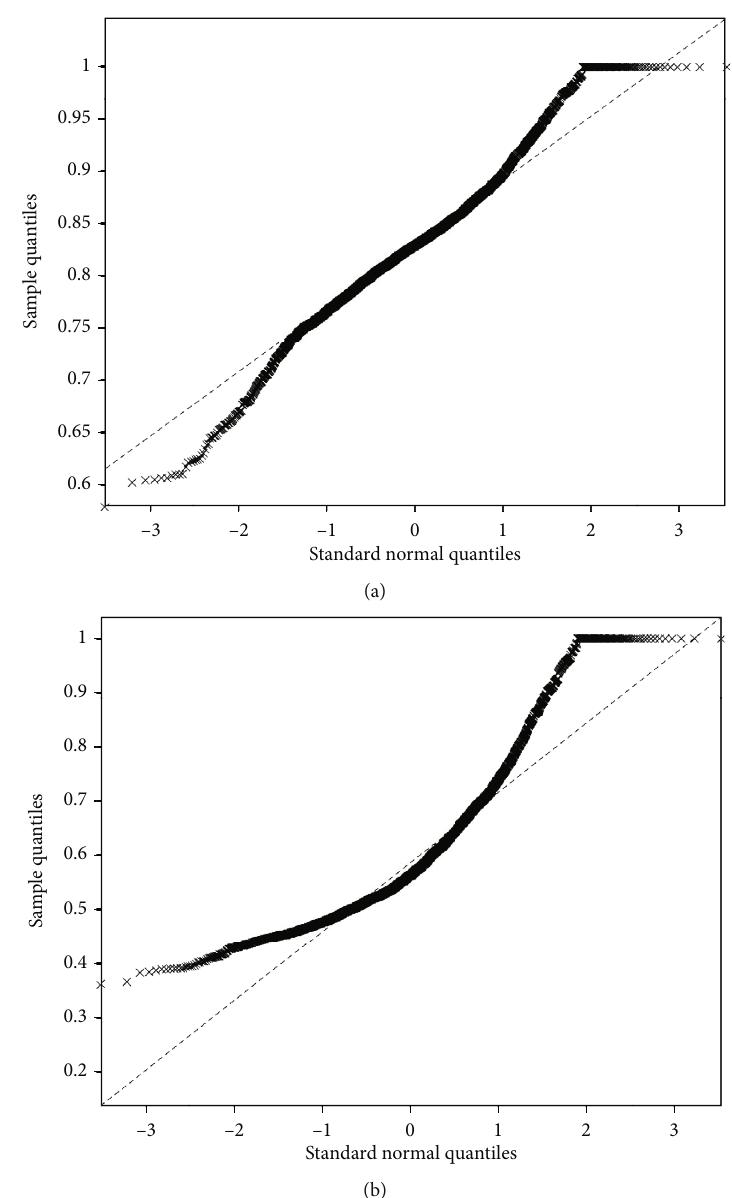
Figure 5: The Pearson r normal distribution quantitative plot (Q-Q plot). (a) CG group Q-Q plot. The data is the normal distribution. (b) DOC Q-Q plot. The data showed a left-skewed